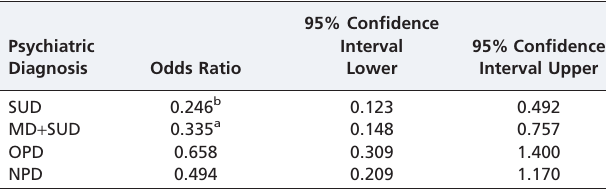
Table 2 - Multiple logistic regression: odds ratio represents the likelihood of adherence to treatment controlling for potential confounding characteristics, with mood disorders as the reference condition (n =